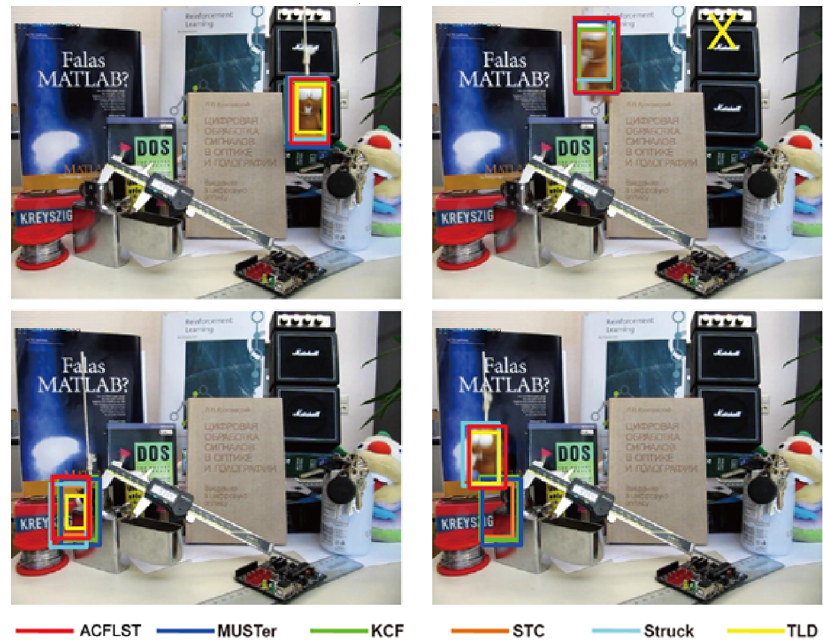
Figure 1. Conclusions of example tracking on the lemming sequence by ACFLST [23], MUSTer [27], KCF [5], STC [24], Struck [4] and TLD [28] (X: no tracking